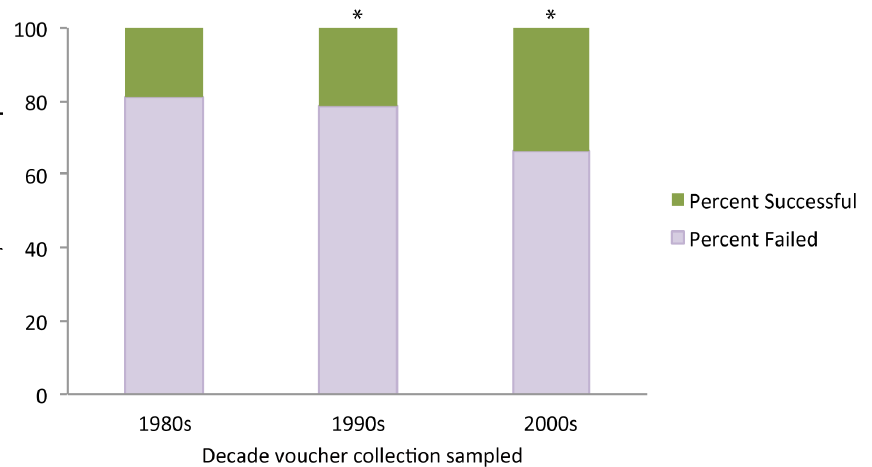
Figure 1. Association between specimen age and PCR amplification success using primers ITS1F and ITS4. Pearson Chi-square test of independence (N=2763, d.f.=2) significant at p , 0.0001. Asterisks denote categories with standardized adjusted residuals significant at a Bonferroni- corrected a =0.00833. See Table S2 for data and post hoc test results.